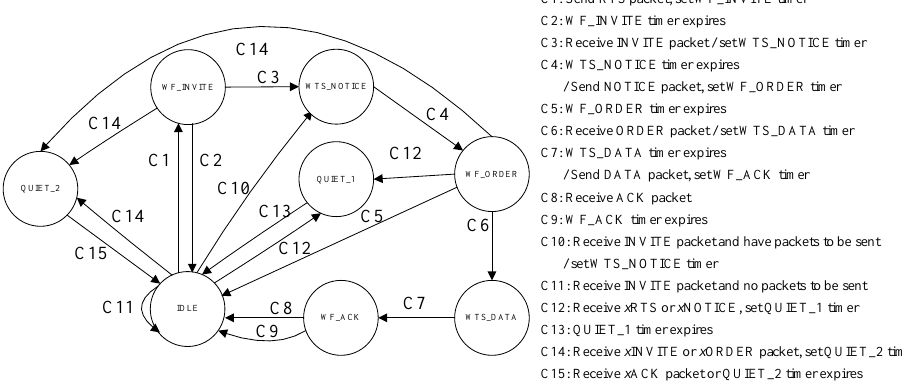
Figure 7. The state transition diagram of a level-2 node in CT-MAC protocol.